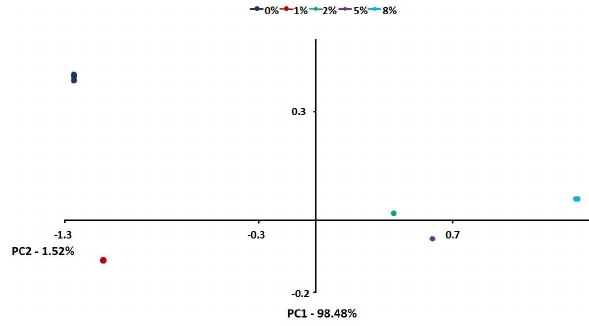
Figure 6: PCA analysis of the color profile of the bread samples replaced with different levels (0%, 1%, 2%, 5%, 8%) of GSMP ac- quired by the e-eye